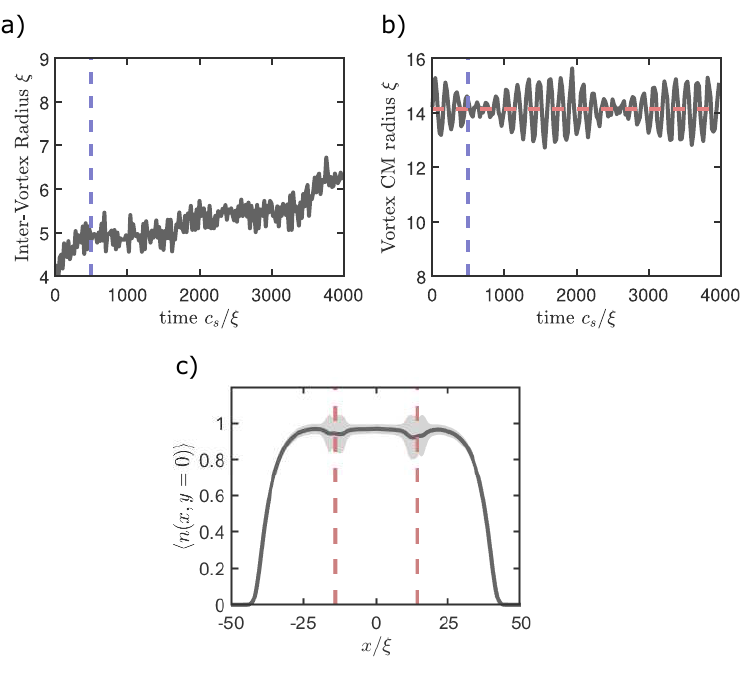
Figure 2. (color online) Simulation in the absence of potential shaking. Here Panels ( a – c ) are equivalent to Panels ( b – d ) of Figure